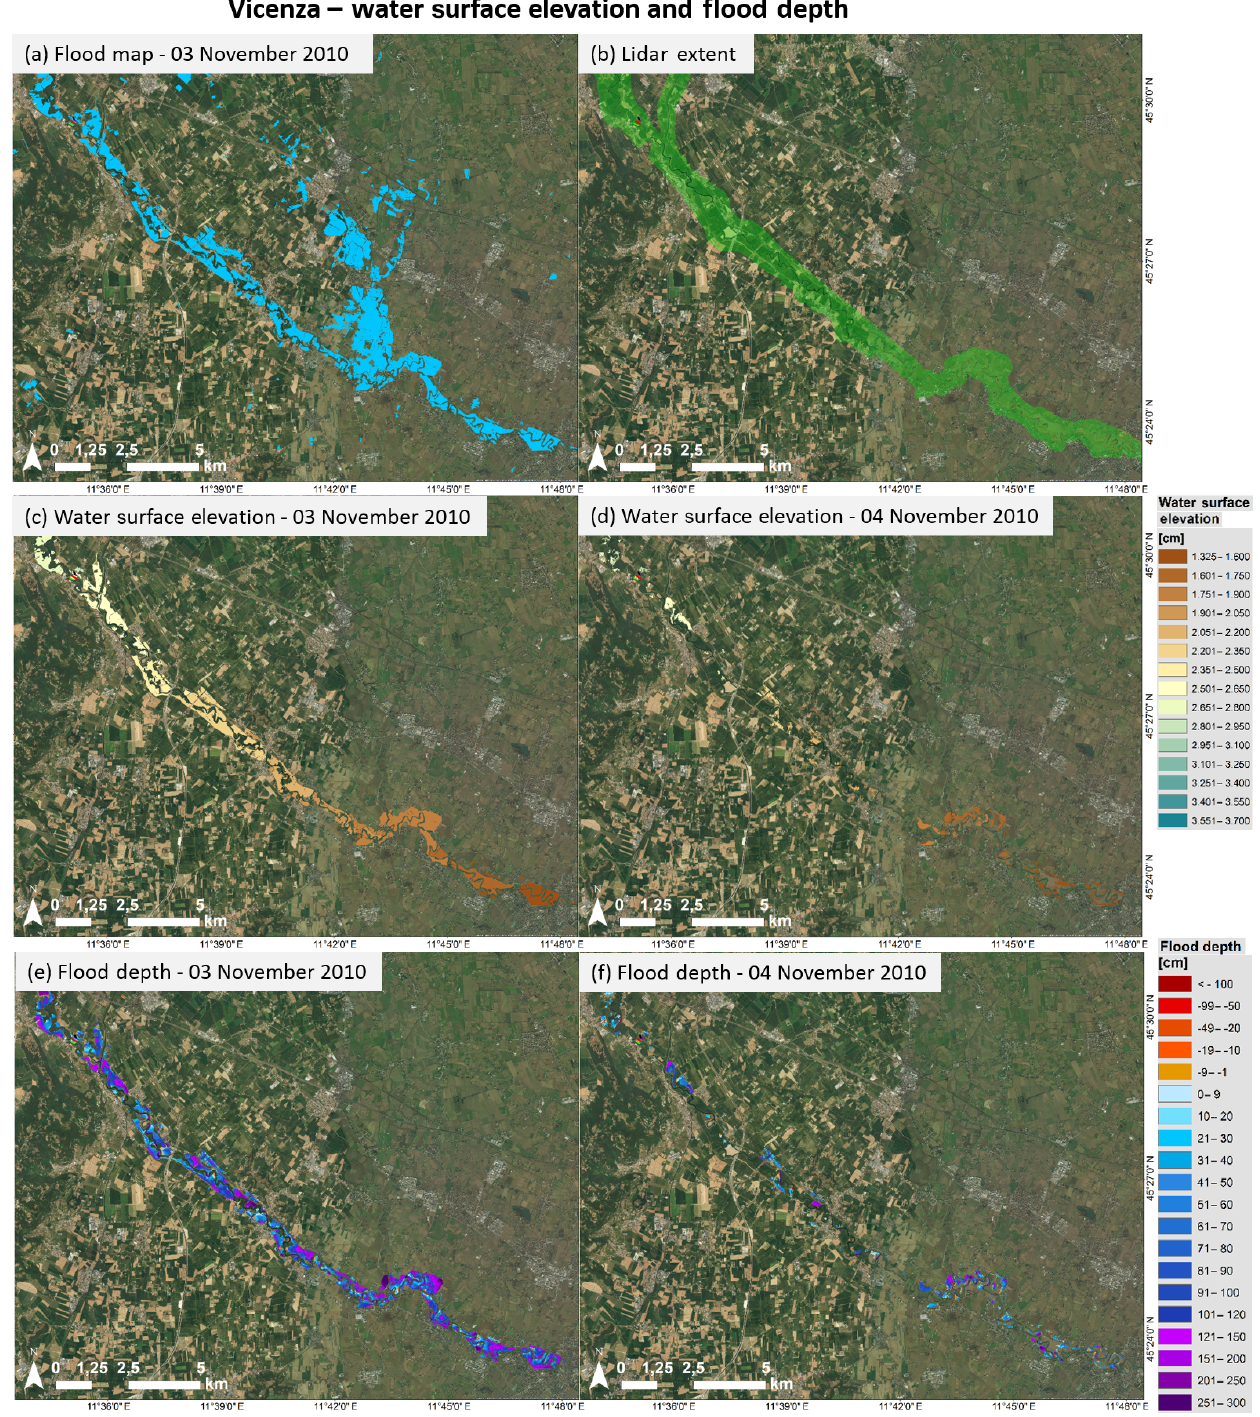
Figure 6. Water surface elevation and flood depth estimation for the Vicenza area of interest on 3 and 4 November. Panel (a) shows the flood map for 3 November and (b) the extent of the lidar data, which do not completely cover the flooded areas. Panels (c) and (d) show water surface elevation, and panels (e) and (f) show flood depth, respectively, for 3 and 4 November. Reddish values in (e) and (f) indicate negative flood depth and therefore an error in the estimation of the water surface elevation